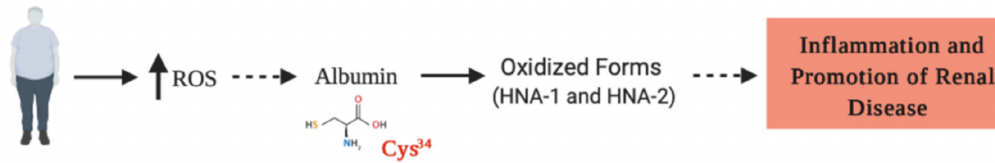
Figure 3. Reactive oxygen species (ROS) are increased in obese people, favoring the oxidized form of HSA (HNA), which in turns, generates an increase in proinflammatory cytokines. Here, we hypothesized (discontinuous lines) that the HNA, particularly oxidized at Cys34, may be generated as a result of obesity, promoting the progression of inflammatory and degenerative injuries, which are crucial for the progression of chronic kidney